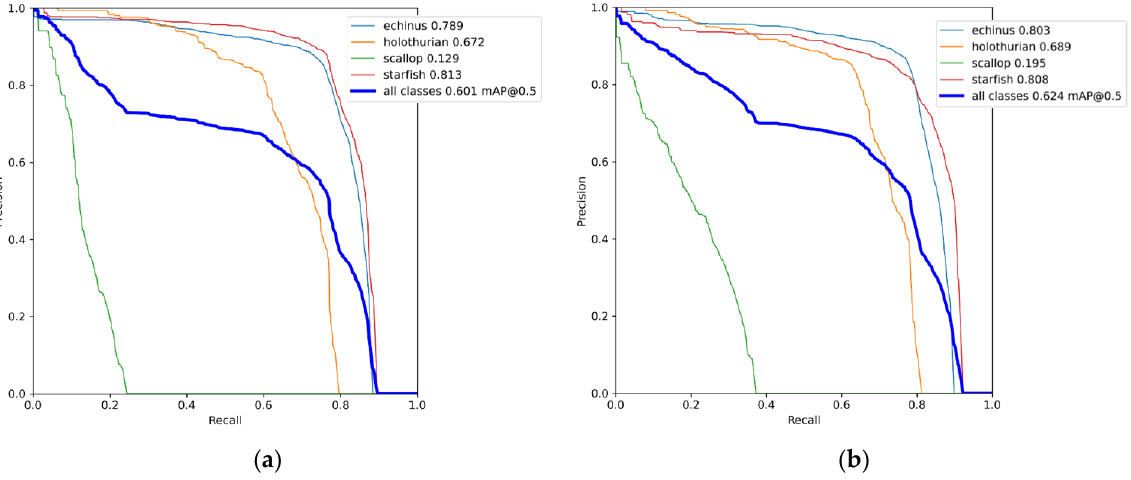
Figure 18. PR curve of the models trained without and with non-overlapping filling of scarce samples: ( a ) PR curve of the model trained without non-overlapping filling; and ( b ) PR curve of the model trained with non-overlapping filling.